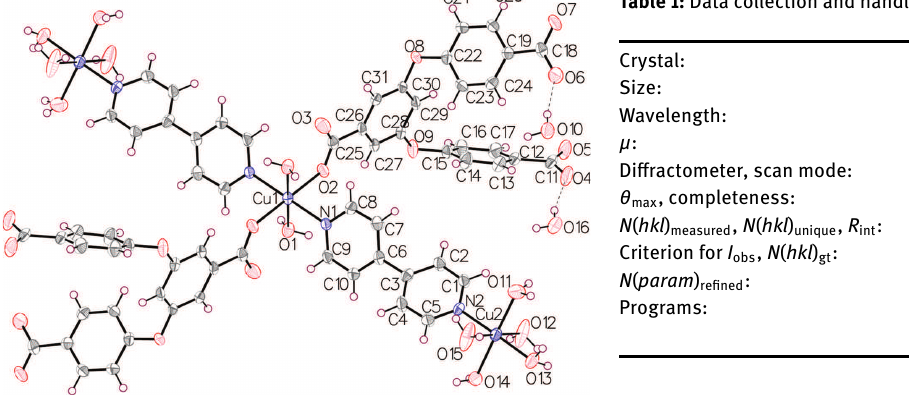
Table 1: Data collection and